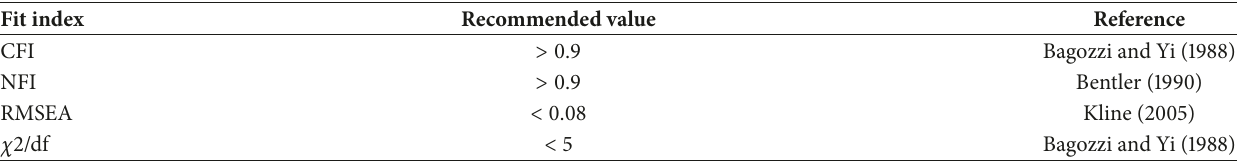
Table 1: The recommended value of fit indices for SEM analysis.